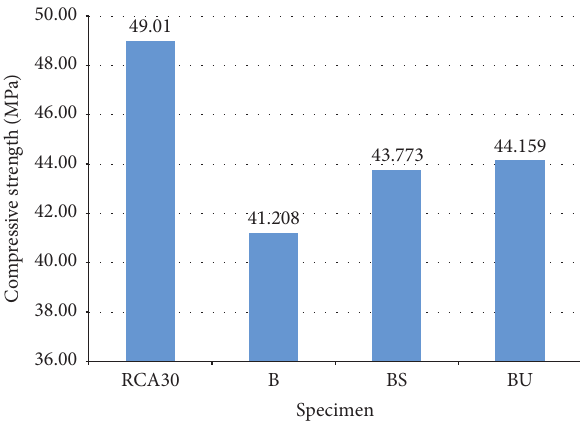
Figure 7: Compressive strength test result of specimen.